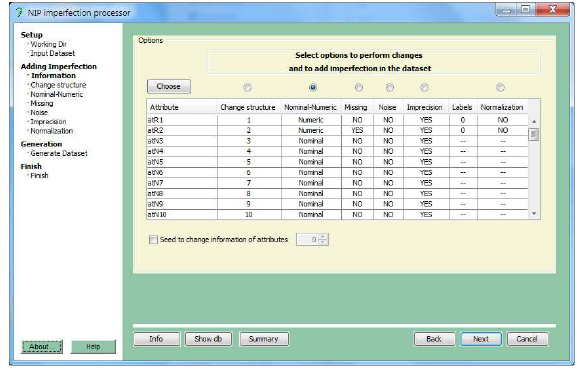
Fig. 5. Screen of summarized